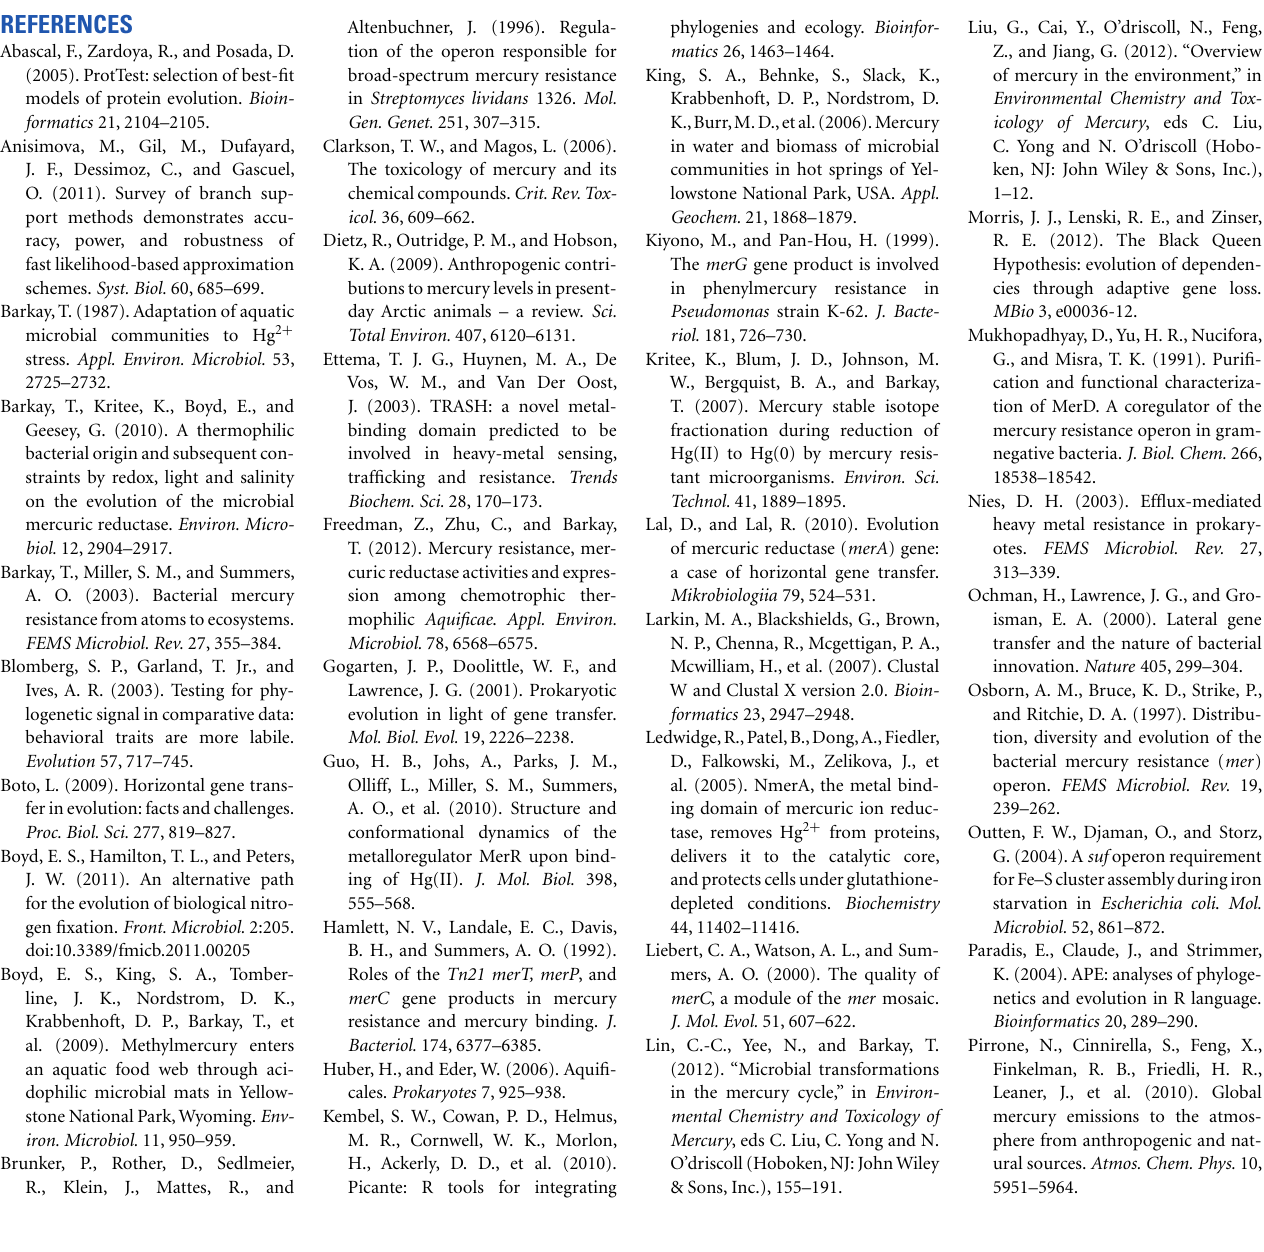
Figure S9 |The taxonomic distribution of merP mapped on the MerA phylogenetic tree, as indicated by blue crosses to the right of the sequence terminal. Phylum level taxonomic rankings are overlaid by color on each lineage. Figure S10 |The taxonomic distribution of merR (divergent orientation) mapped on the MerA phylogenetic tree, as indicated by blue crosses to the right of the sequence terminal. Phylum level taxonomic rankings are overlaid by color on each lineage. Figure S11 |The taxonomic distribution of merR (convergent orientation) mapped on the MerA phylogenetic tree, as indicated by blue crosses to the right of the sequence terminal. Phylum level taxonomic rankings are overlaid by color on each lineage. Figure S12 |The taxonomic distribution of merT mapped on the MerA phylogenetic tree, as indicated by blue crosses to the right of the sequence